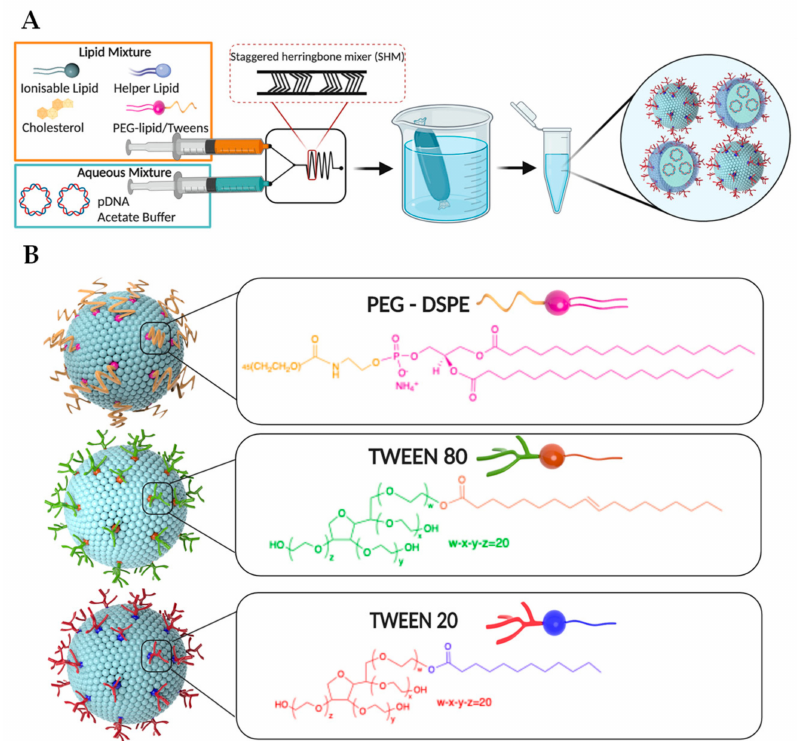
Figure 1. Schematic presentation of ( A ) a scalable, rapid, and reproducible microfluidic mixing technology (NanoAssemblr ® ) used in this work to prepare LNPs and ( B ) three types of LNPs stabilized by PEG-DSPE, Tween 80, or Tween